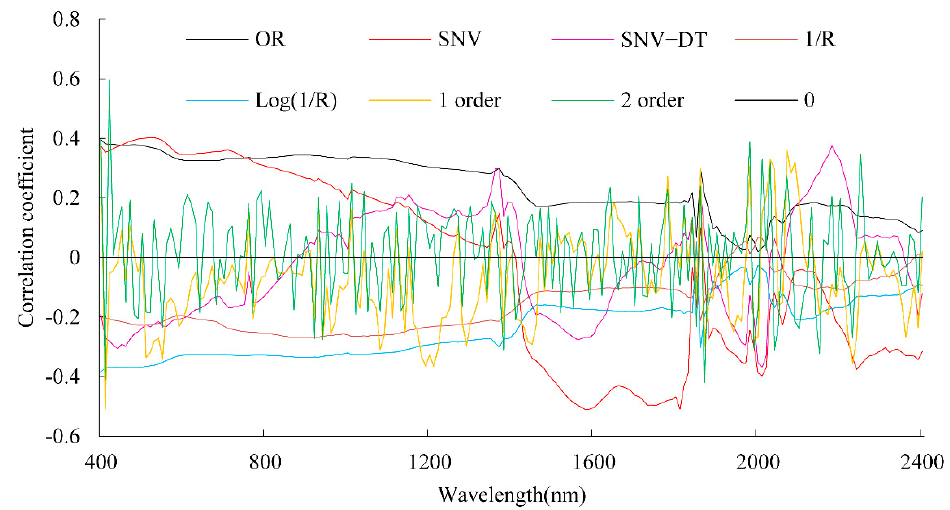
Figure 4. One-dimensional correlation coefficients between EC and partial conversion transformation reflectance (OR, SNV, SNV-DT, 1/OR, Log (1/OR), 1 and 2 order derivative) in the range of 400~2400 nm.